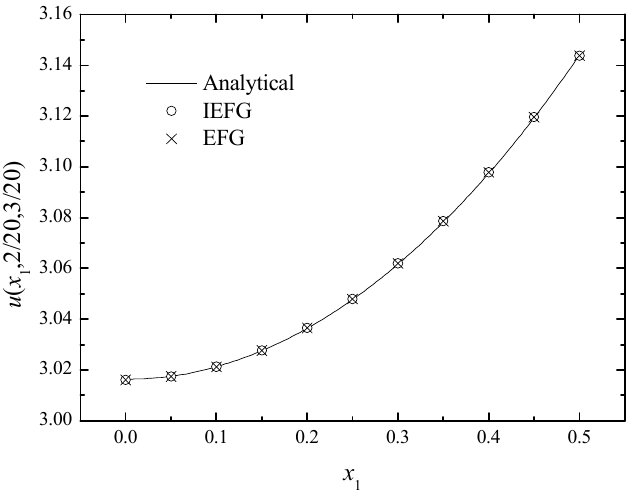
Figure 3. The contour plot of nodes, numerical solutions, and the relative errors.